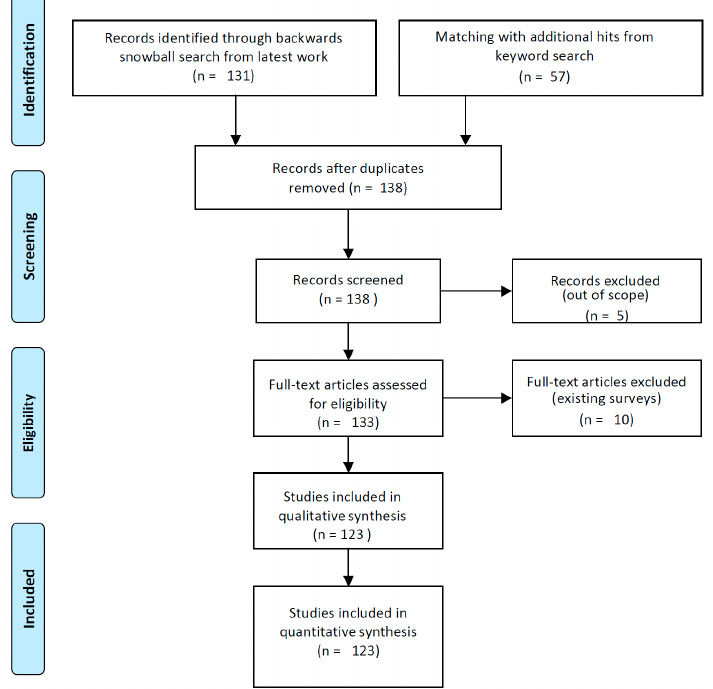
Figure 2. Applied workflow for systematic literature search (adapted from [29]).